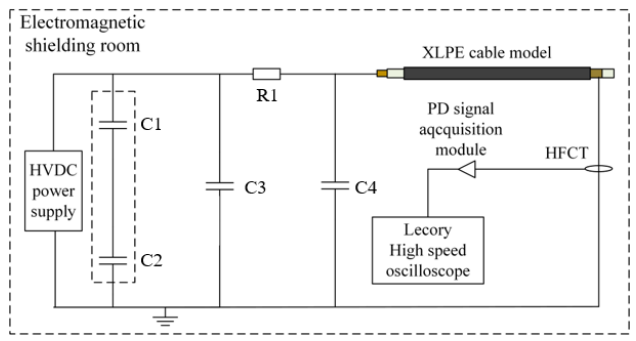
Figure 3. PD Experiment and Detection System of DC XLPE Cable.